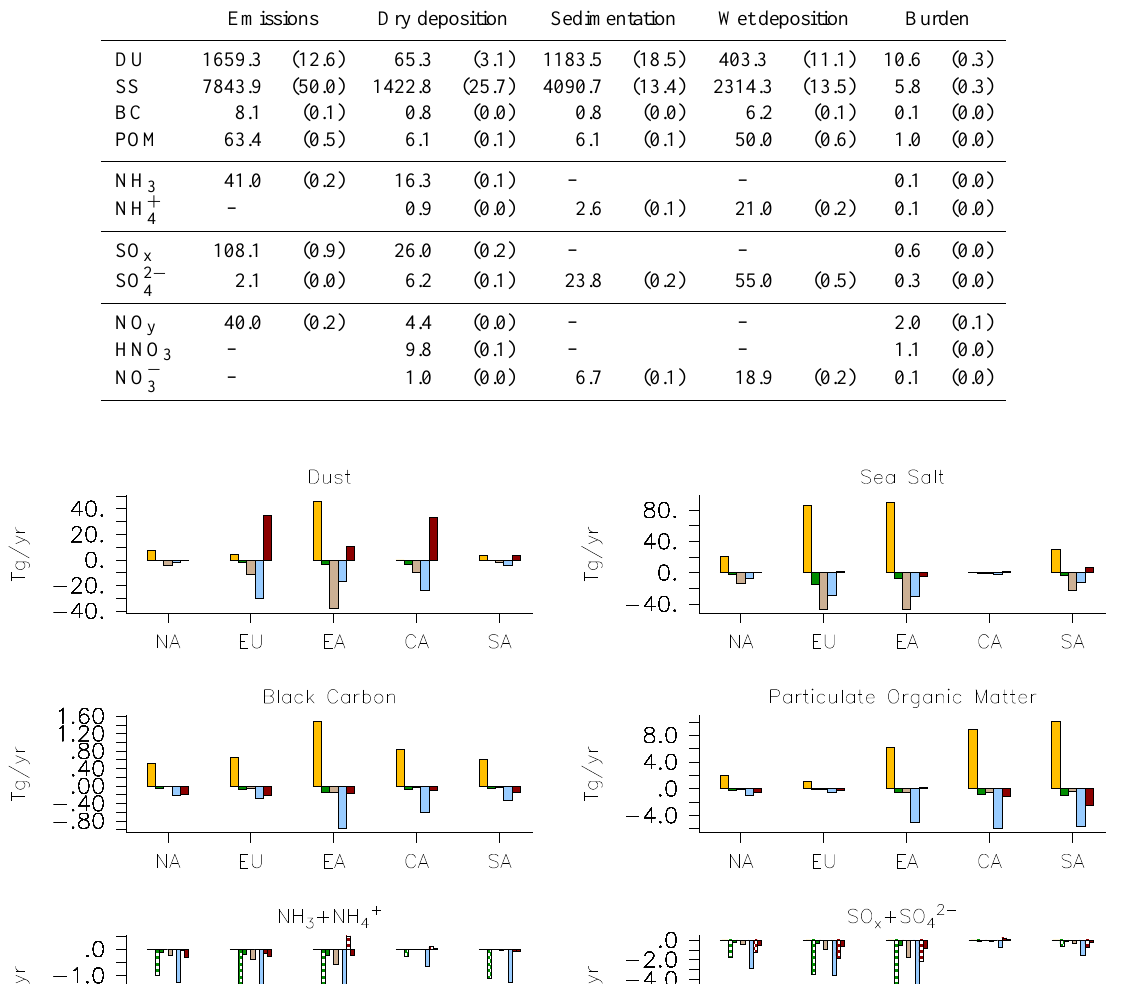
Table 4. Global aerosol budget. All units in Tg(species)yr − 1 , except nitrogen and sulfur compounds (expressed as TgNyr − 1 and TgSyr − 1 , respectively). NO y includes NO, NO 2 , peroxyacytyl nitrate (PAN), NO 3 , HNO 4 and N 2 O 5 , and not nitric acid and aerosol nitrate. SO x includes SO 2 , H 2 SO 4 and DMS, and not aerosol sulfate. The yearly standard deviation is listed in parenthesis.